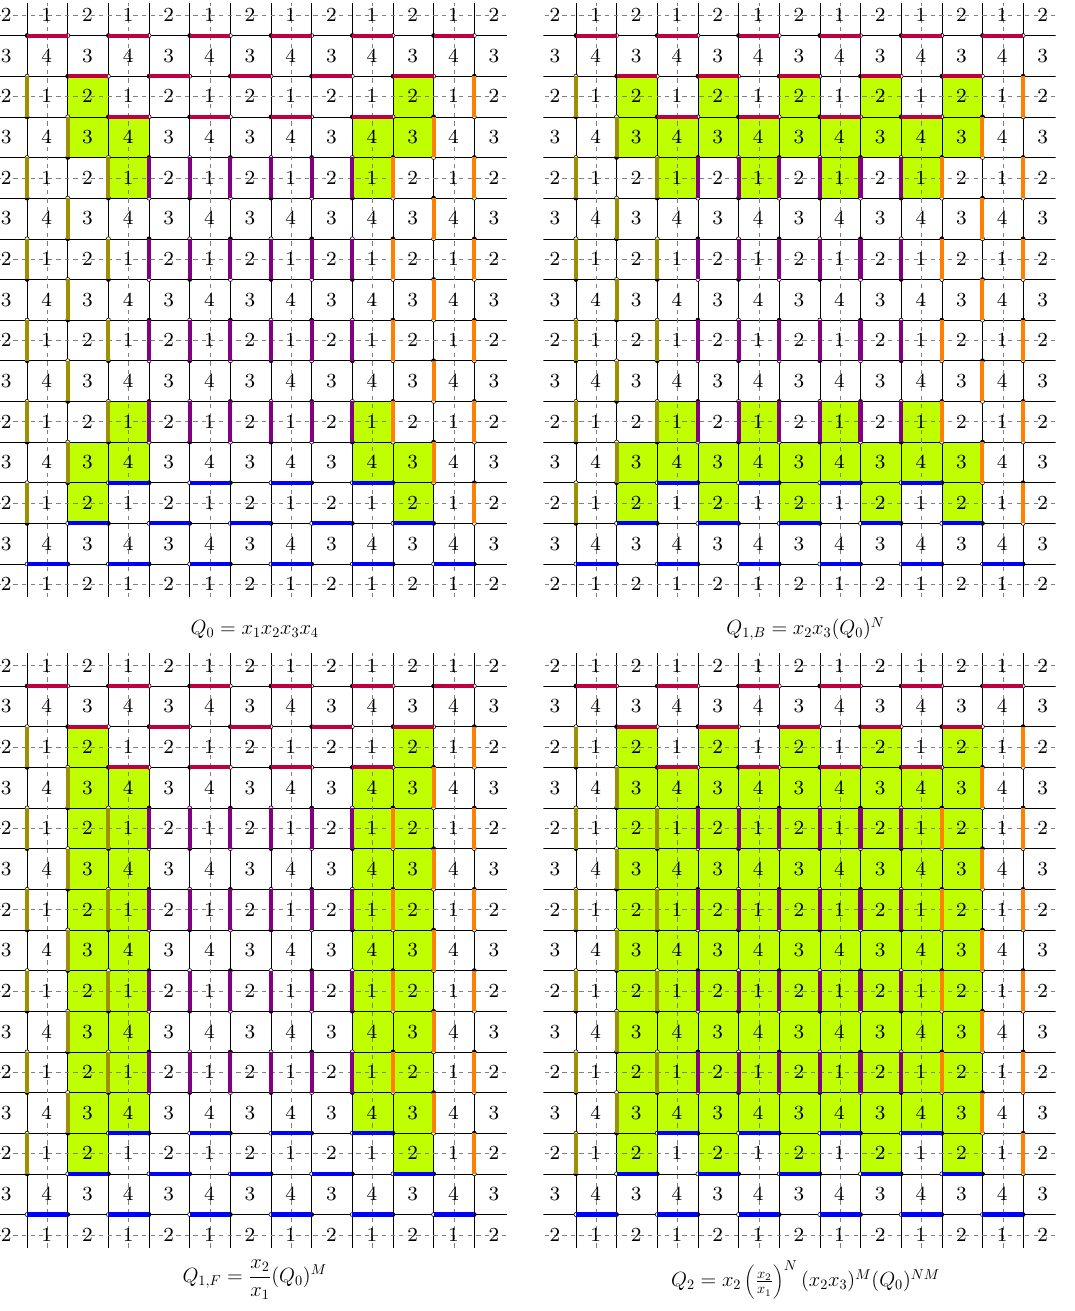
0 drawn. Faces involved in